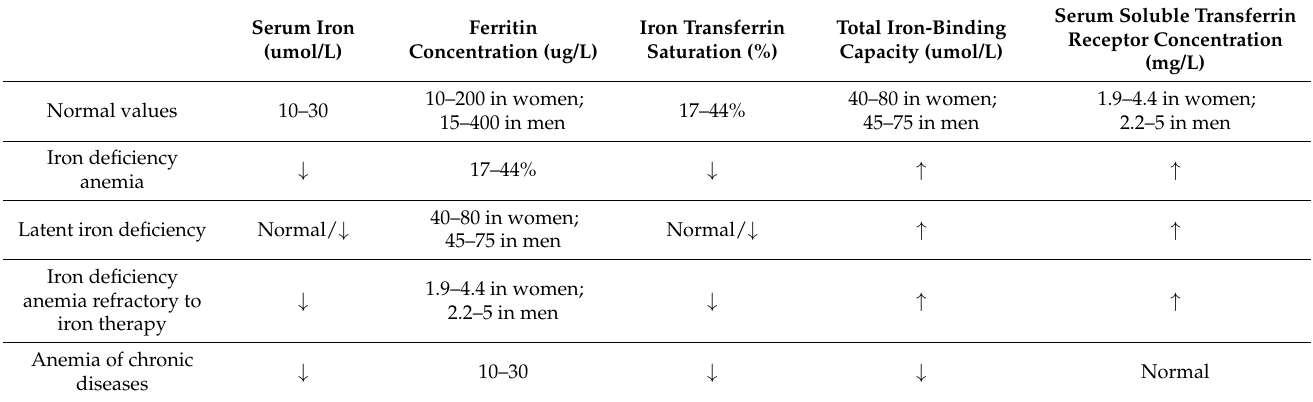
Table 2. Changes in iron metabolism parameters in iron deficiency diseases.